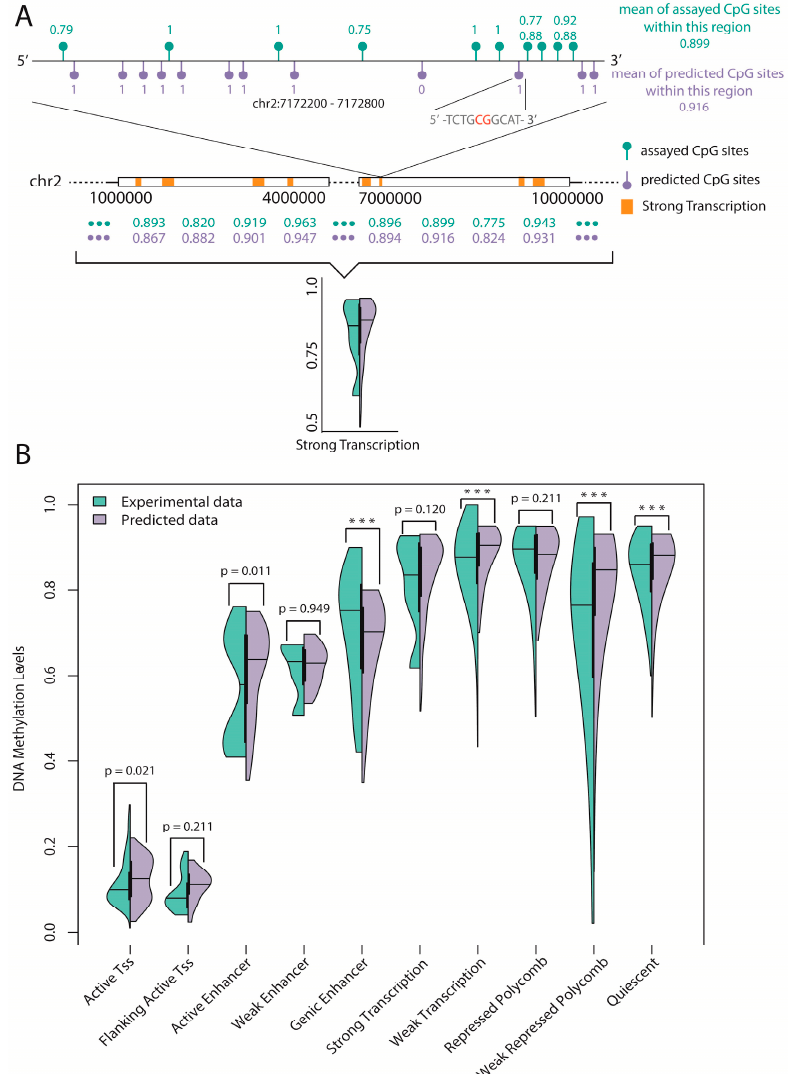
Figure 4. Statistical tests of the experimental data and the predicted data on 10 functional regions: ( A ) the computing procedure for one of 10 regions (Strong Transcription); and ( B ) the semi-violin plots show the distributions of average DNA methylation levels on 10 functional genomic regions. The p values of the six regions confirmed to be statistically consistent are labeled, and *** represents p < 0.0001.